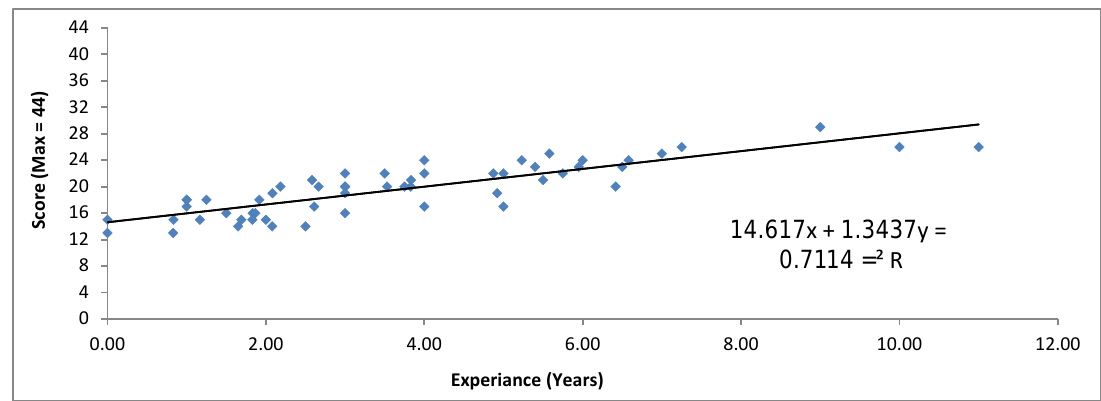
Fig. 4. Hierarchy for operations manager selection problem